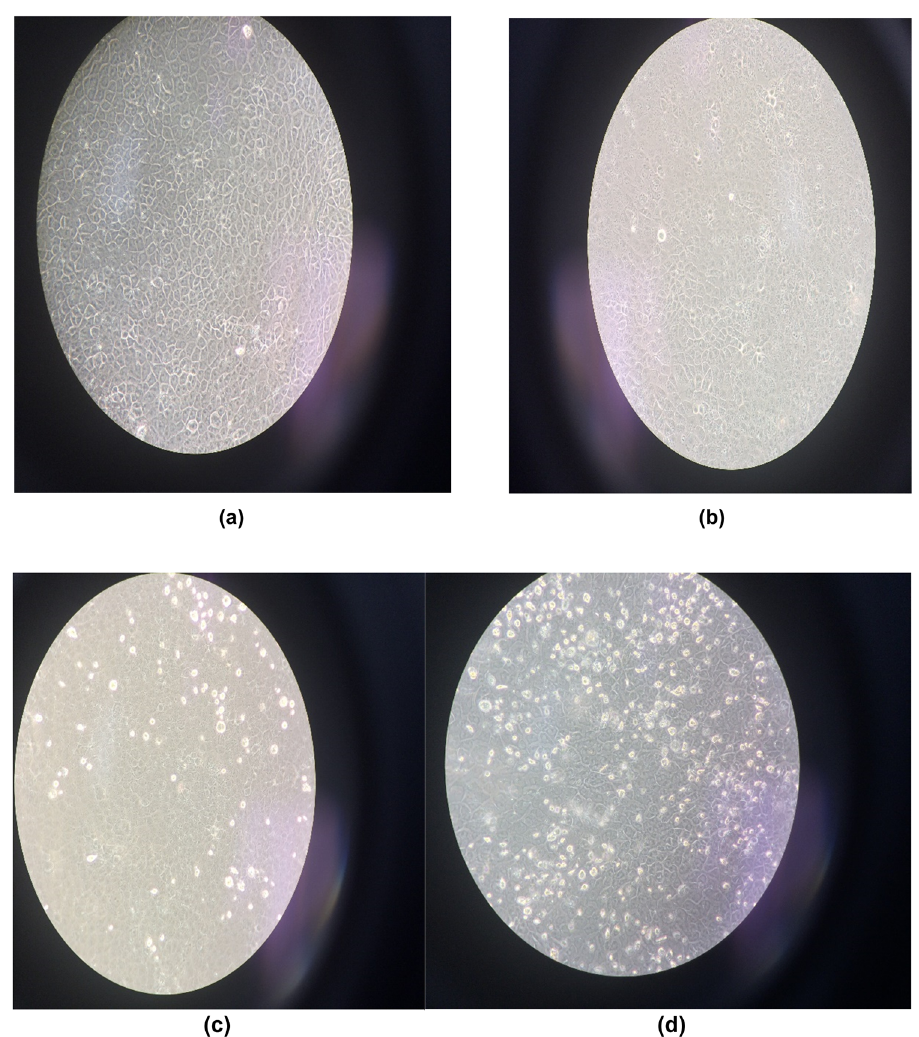
Figure 7: ( a ) MDCK under microscope at 0 time control condition. ( b and c ) MDCK under microscope after the addition of plant extract 16 and 24 h, respectively. ( d ) MDCK under microscope after addition with DMSO for 8